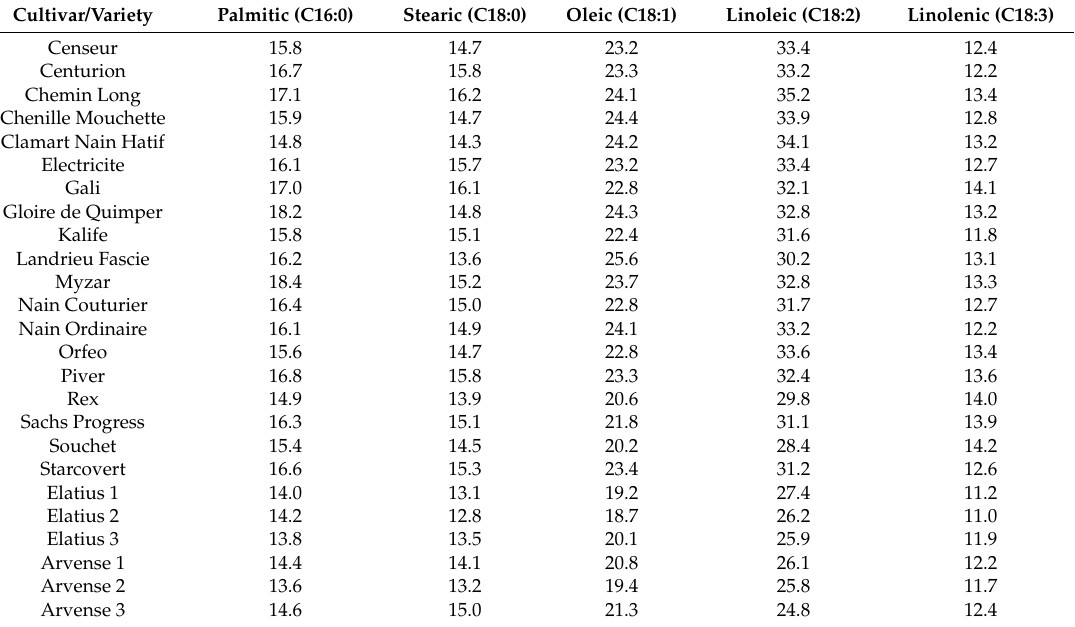
Table 1. Composition of fatty acid of the 25 accessions of French